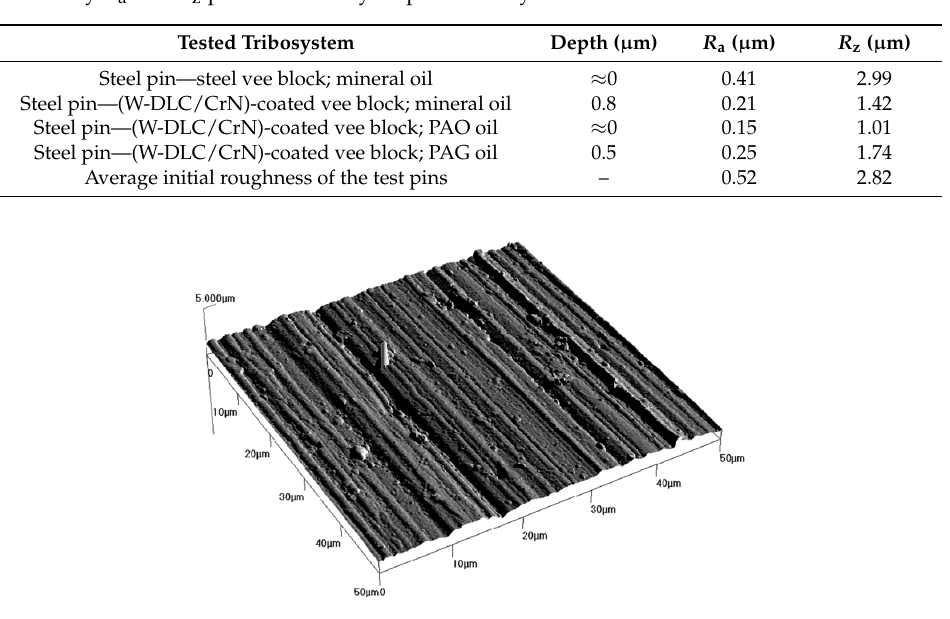
Figure 5. Optical profilometric images of the wear scars on the vee blocks: ( a ) Uncoated vee block lubricated with the mineral oil; ( b ) (W ‐ DLC/CrN) ‐ coated vee block lubricated with the mineral oil; ( c ) (W ‐ DLC/CrN) ‐ coated vee block lubricated with the PAO oil; and ( d ) (W ‐ DLC/CrN) ‐ coated vee block lubricated with the PAG oil. Table 1. The average depths of the wear tracks on the test pins and surface roughness of the worn area measured by R a and R z parameters — stylus profilometry measurements.